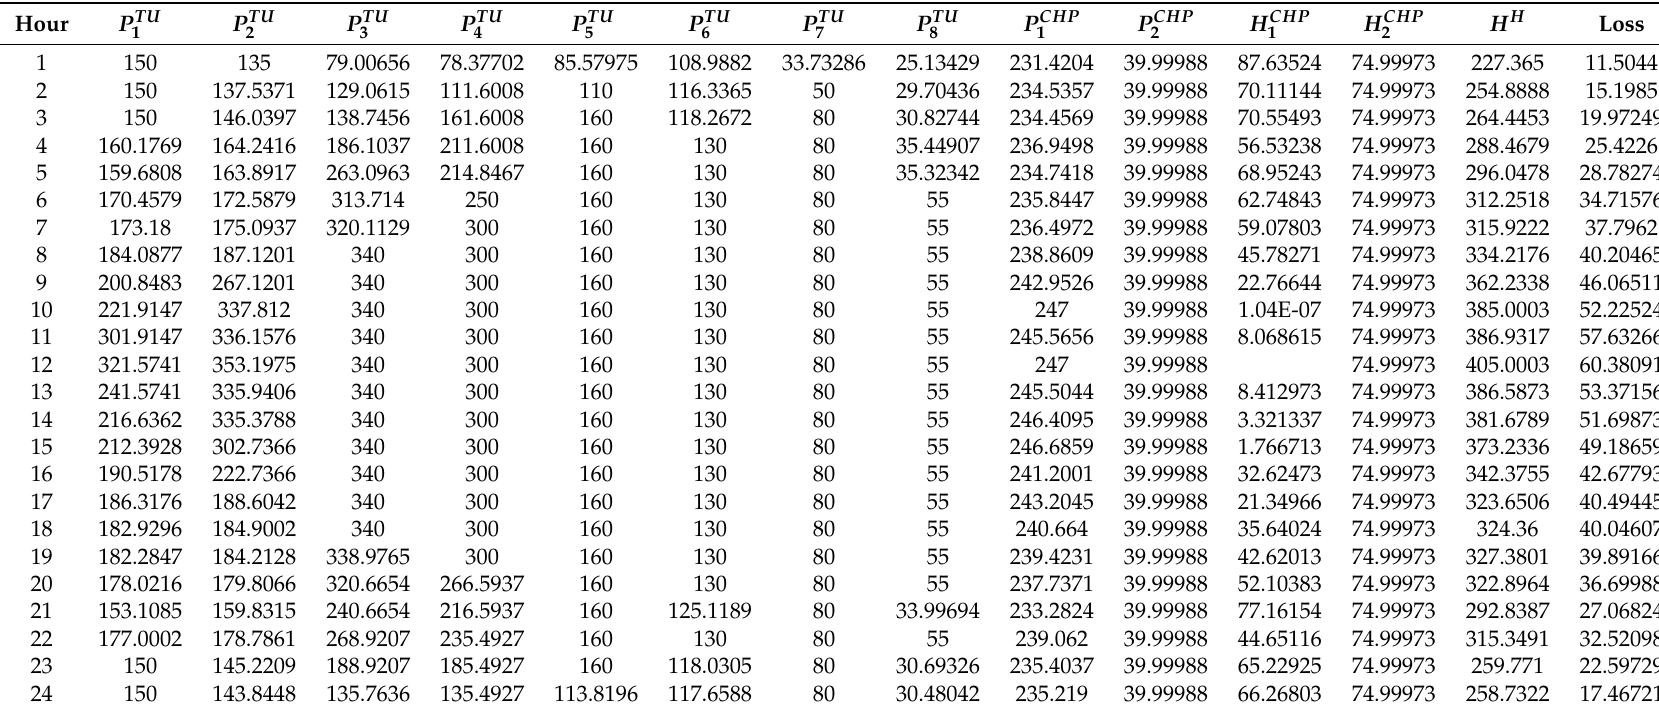
Table A5. Detailed power flow results for Case